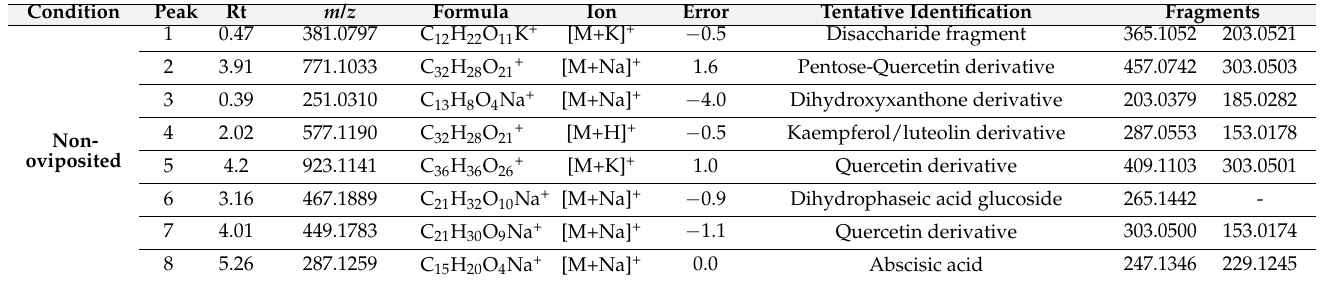
Table 3. Tentative identification of the main differential chemical markers found in “Criollo” mango peel from “untargeted metabolomic analysis” of upper and shaded mango peel sections into which A. obliqua females were forced to lay eggs into or that were devoid of